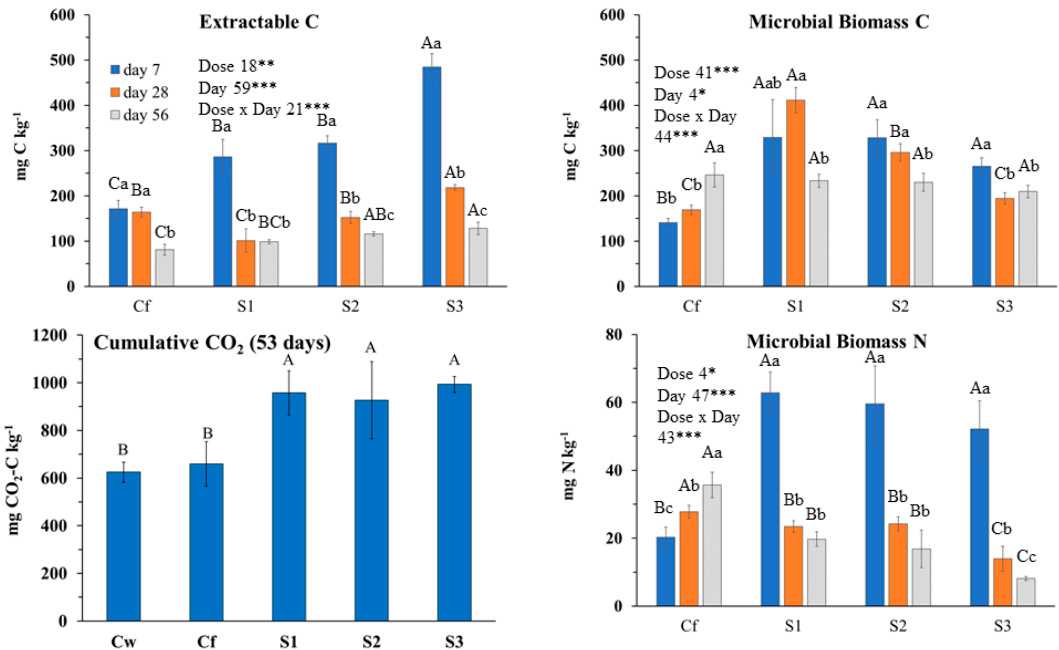
Figure 5. Biochemical soil variables determined at 7, 28 and 56 incubation days after Santolina chamaecyparissus L. essential oil applied by irrigation at di ff erent concentrations: Cw (no Fitoil and EO application), Cf (0.03 µ L Fitoil g − 1 of soil and no EO application), T1 (0.03 µ L Fitoil g − 1 of soil and 0.31 µ L EO g − 1 of soil), T2 (0.03 µ L Fitoil g − 1 of soil and 0.67 µ L EO g − 1 of soil), and T3 (0.03 µ L Fitoil g − 1 of soil and 0.93 µ L EO g − 1 of soil). Reported results are means ± standard deviations ( n = 4). The percentage of variance explained by incubation day, dose of essential oil and by their interaction are also reported. Capital letters indicate significant di ff erences among doses within the same incubation day. Lower case letters indicate significant di ff erences among incubation days within the same dose. *, ** and *** indicate significant at p < 0.05, p < 0.01 and p < 0.001; NS, not significant.